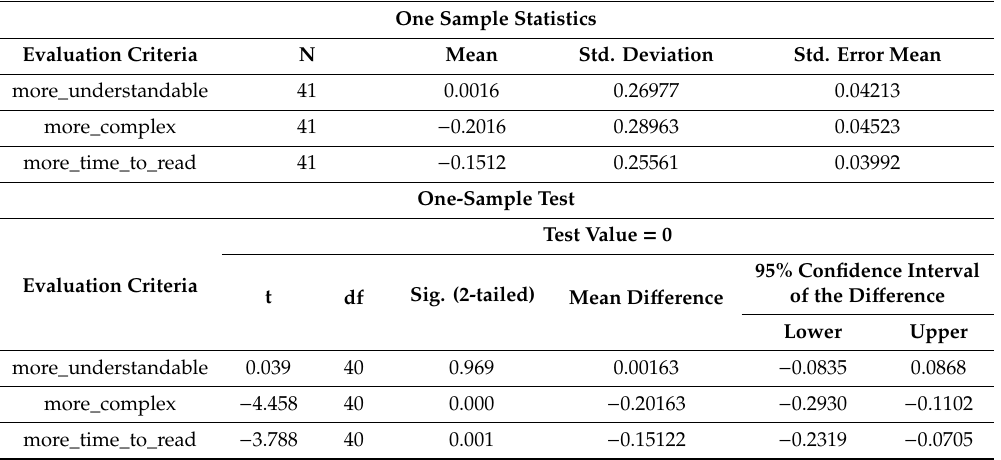
Table 5. Programmers data—new comment readability t -test values.